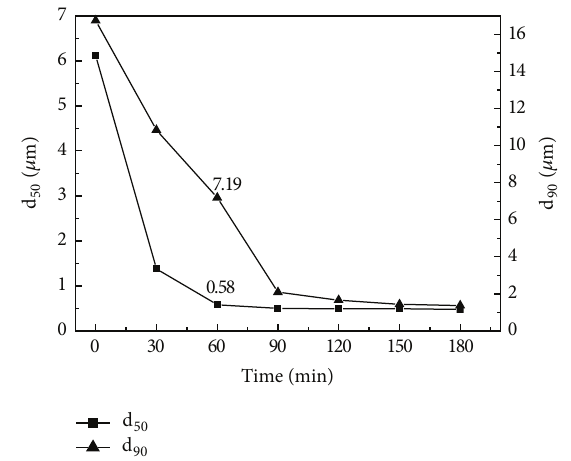
Figure 1: Effect of grinding time on granularity about d 50 and d 90 of